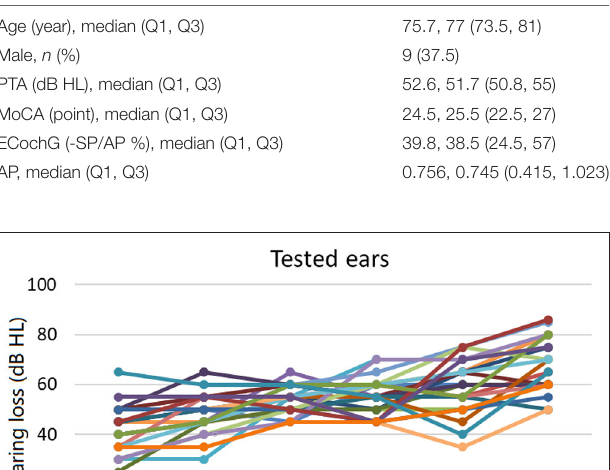
Table 1 . Audiometric thresholds of subjects’ tested ears are shown in Figure 1 .